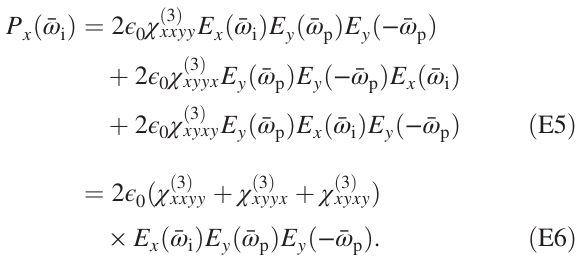
FIG. 15. Asymmetric magnitude of the TF “ cut ” U s;s due to interference between PDC and XPM. Top-left panel: Simulated cut with only PDC. Bottom-left panel: Simulated cut with only XPM. Right panel: Simulated cut with PDC and